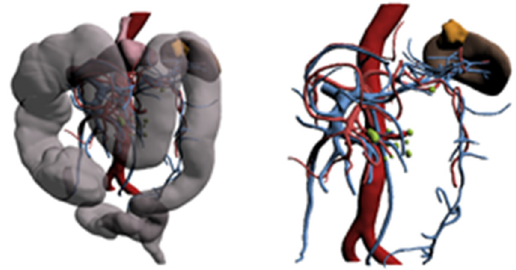
Figure 8. 3D reconstruction (Case 4).